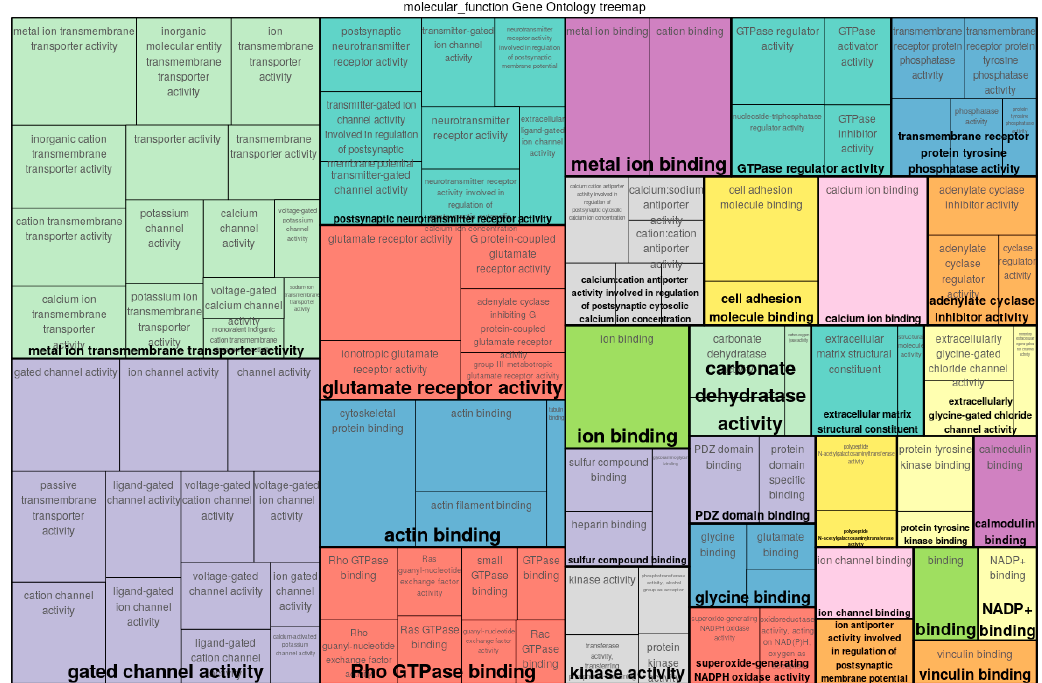
Figure 7. Gene Ontology (GO) treemap for genes associated with immunity to bovine tuberculosis. The boxes are grouped together based on the upper-hierarchy GO term, which is written in bold